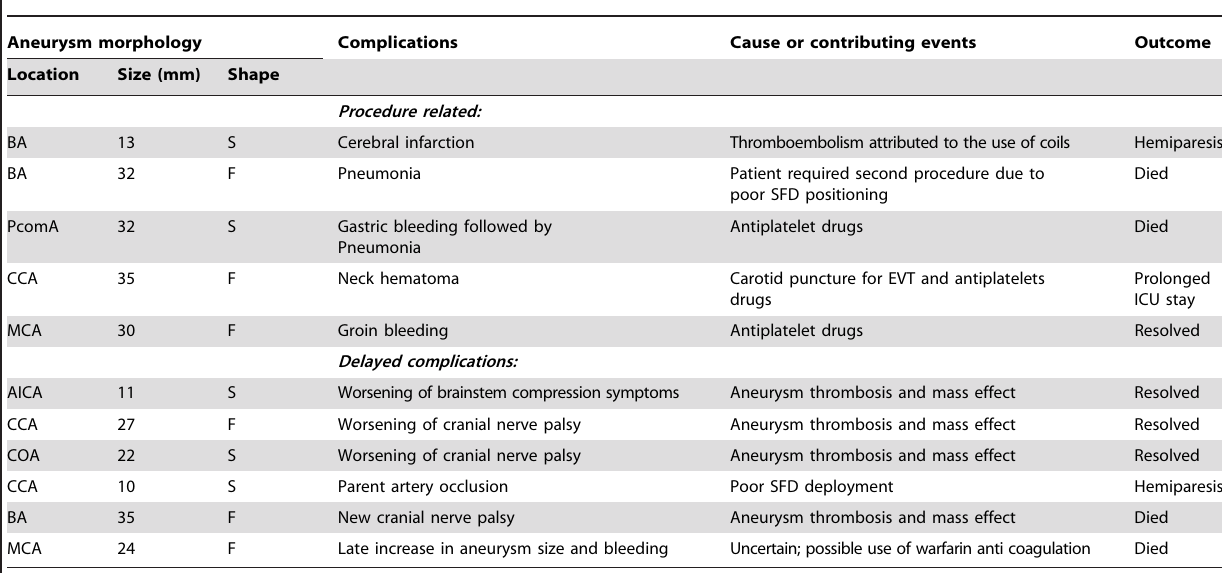
Table 2. Clinical complications observed in patients treated with SFD.